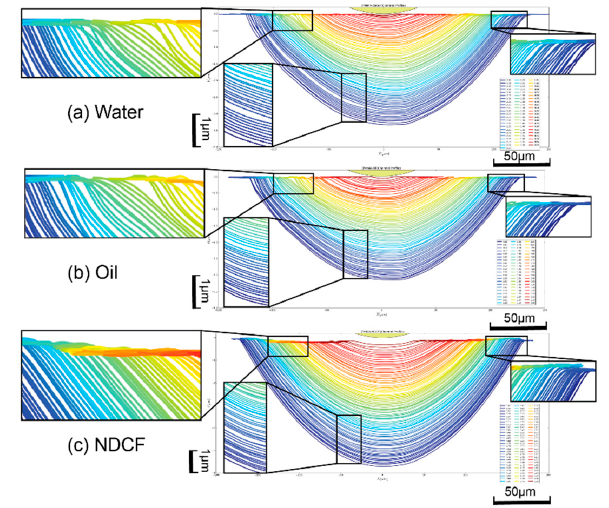
Figure 4. Cross-sections of grove profiles at various DoCs ranging from 0.05 to 3.30 µ m with ( a ) water, ( b ) oil and ( c ) NDCF. Since DoC is much smaller than the groove diameter, the vertical scale is plotted with a higher magnification than the horizontal one.